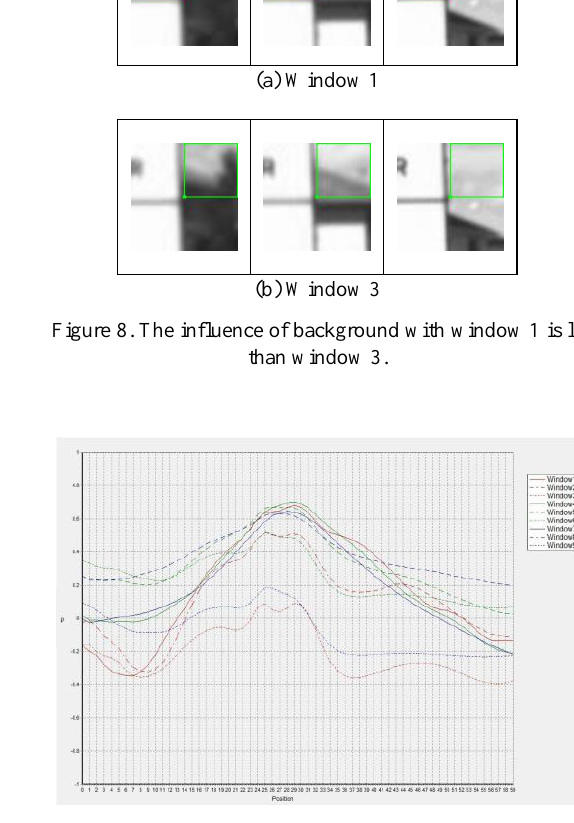
Figure 9. Different correlation coefficients of the 9